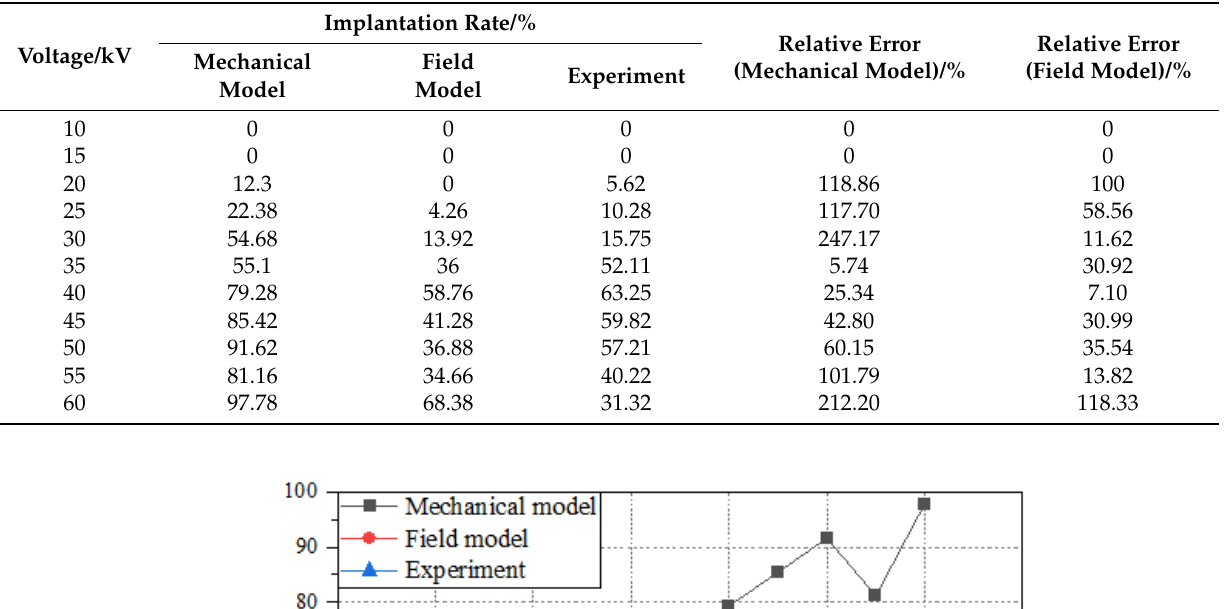
Table 4. Results for different pole plate voltage.